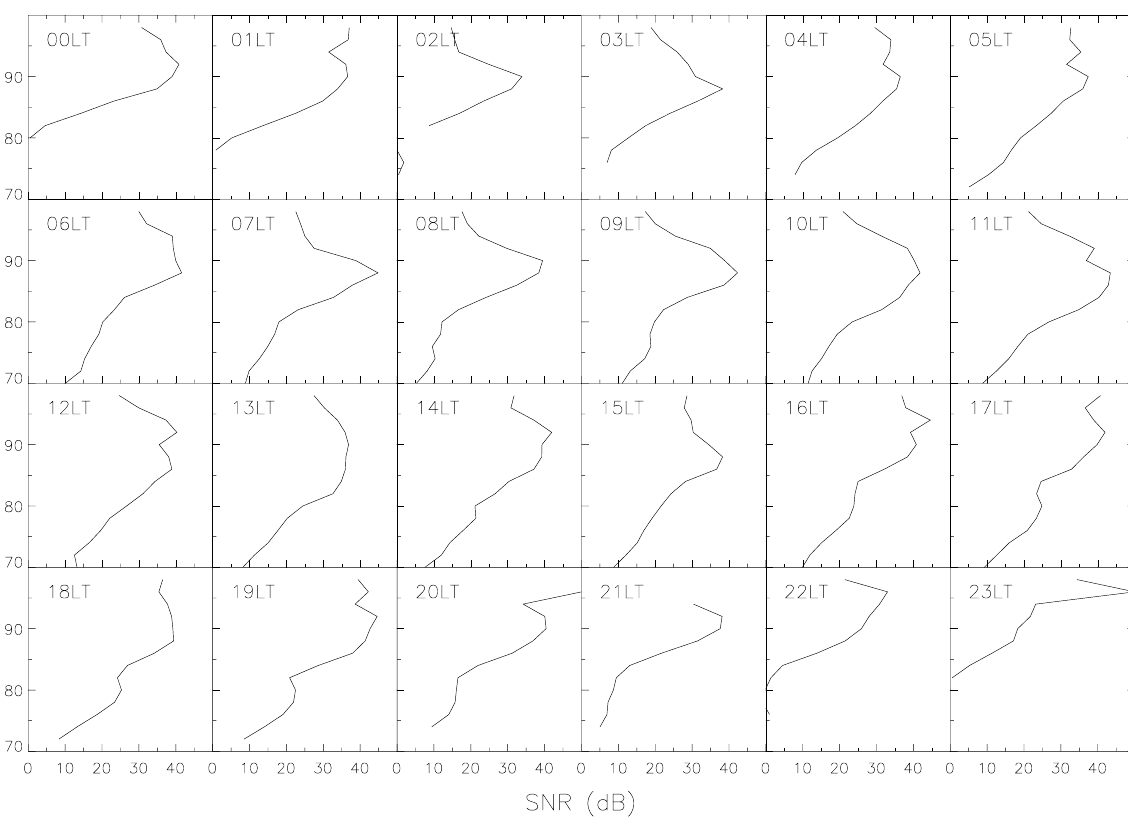
Fig. 2. The hourly averaged SNR profiles for 16 January